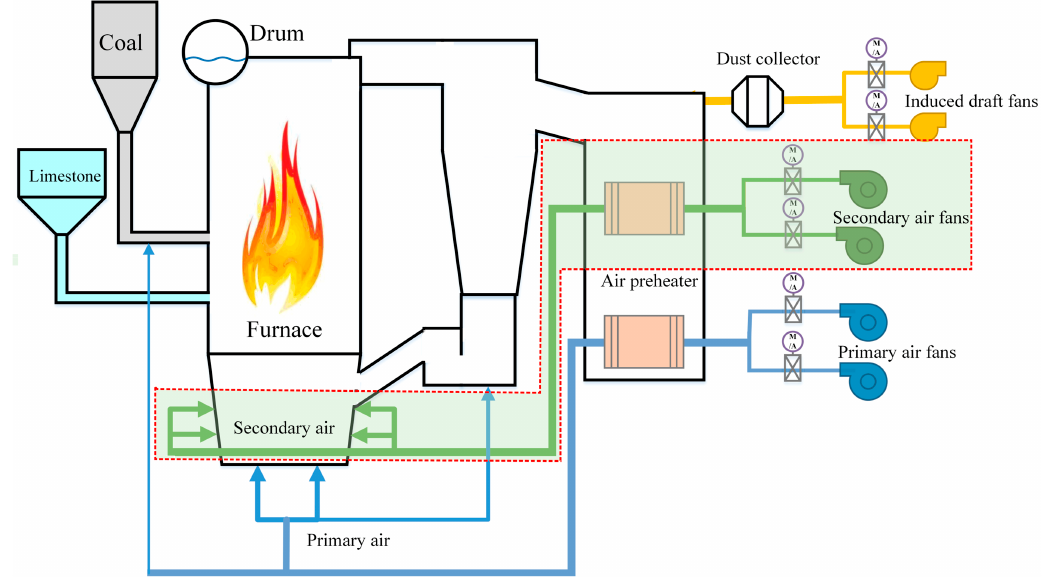
Figure 11. Configuration diagram of the air and smoke system in a CFB unit.